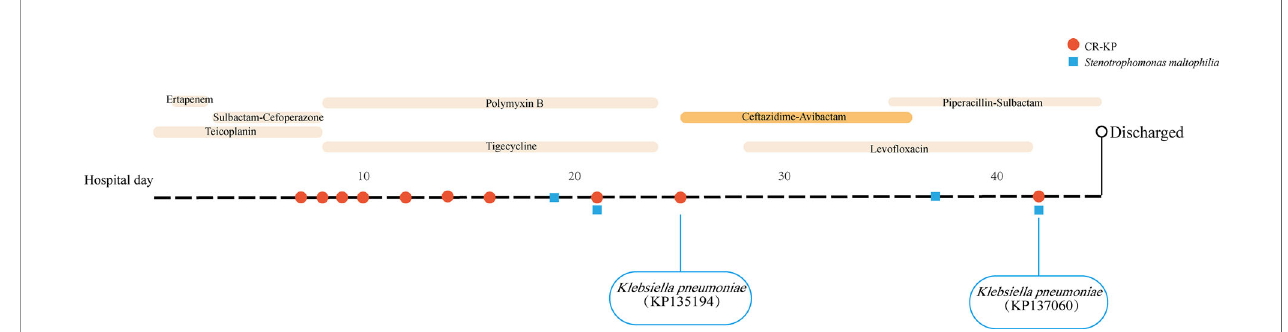
FIGURE 1 | Time courses of infection and treatment of the patient with carbapenem-resistant K.